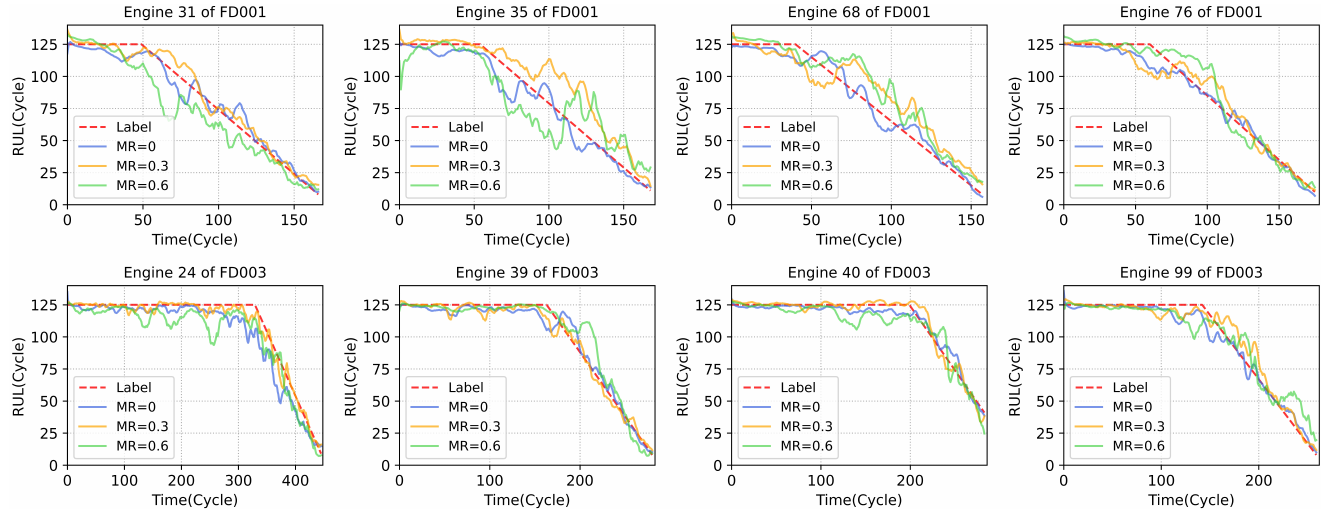
Figure 4. The RUL prediction results of SMTN under different missing rates.